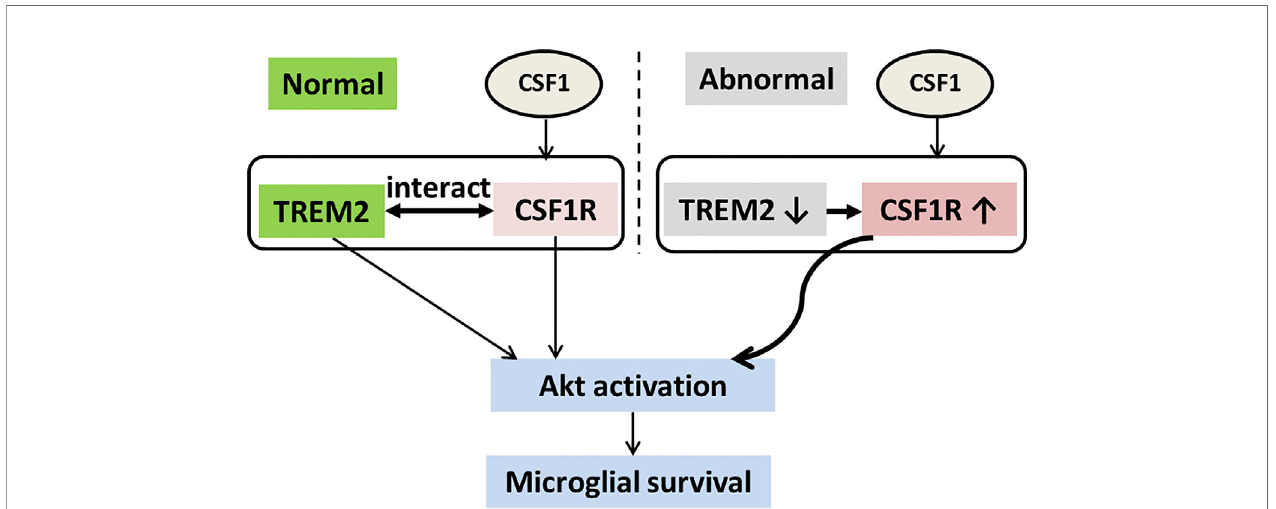
FIGURE 8 | Schematic model of TREM2 and CSF1R interaction in microglial survival. TREM2 and CSF1R interact with each other, both of which promote microglial survival through the Akt pathway. CSF1R expression is increased and has elevated response to CSF1 for Akt activation in Trem2 de fi cient